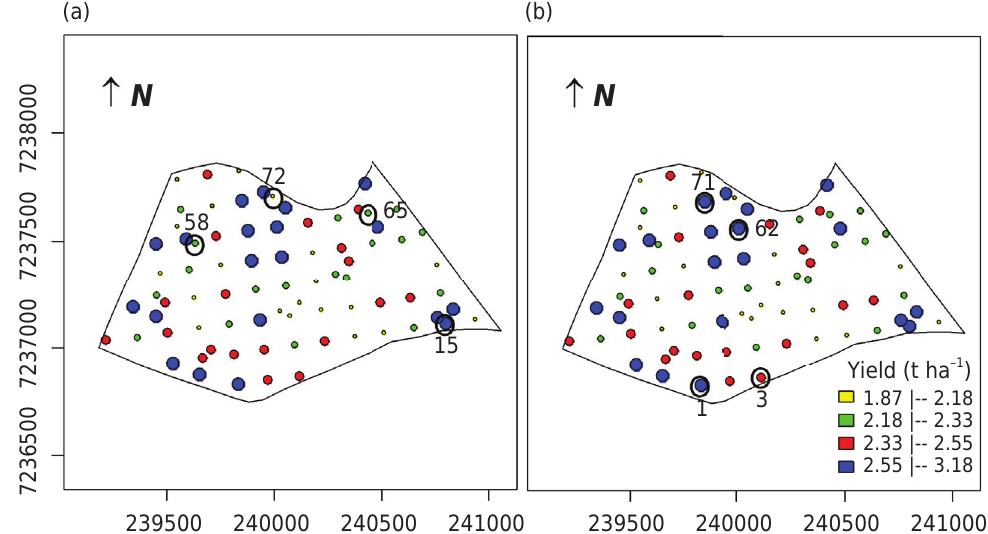
Figure 4. Post-plot graph of soybean yield (t ha -1 ) in the experimental area identifying influential samples: (a) the Gaussian spatial linear model (GSLM) and (b) the slash spatial linear model